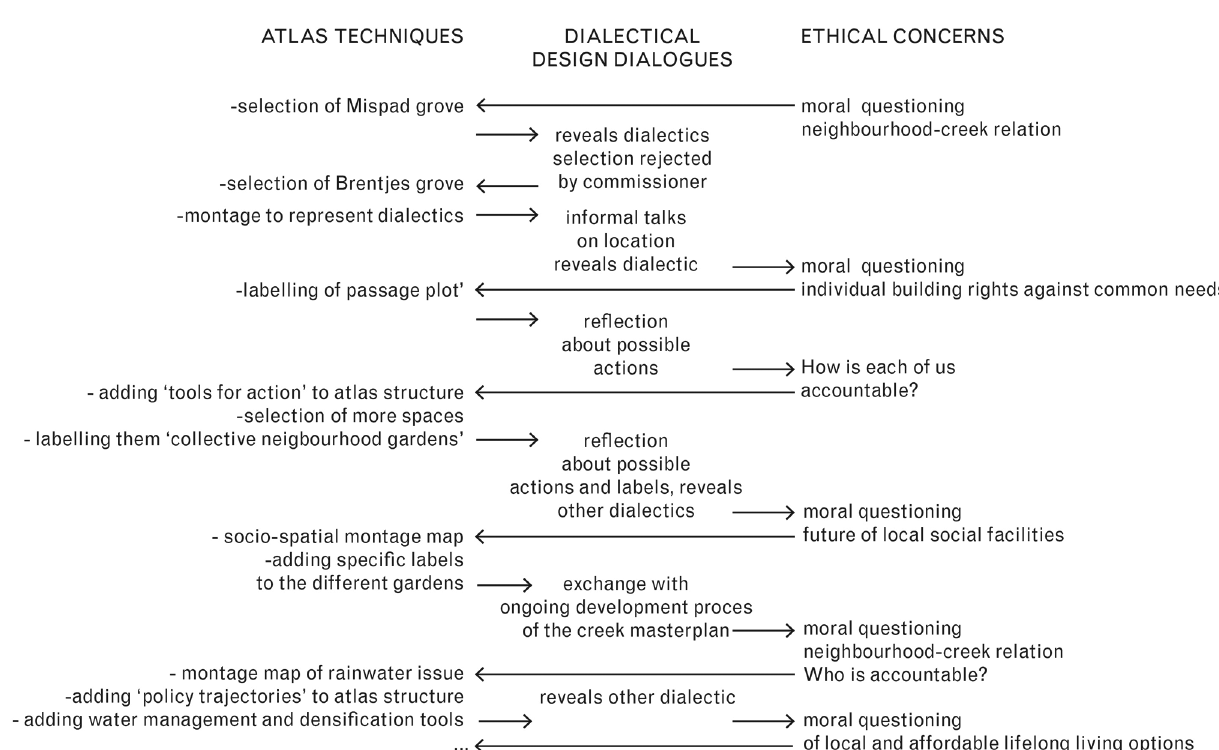
Figure 3. Interplay between atlas techniques and ethical questions within dialectical design dialogues. Source: Barbara